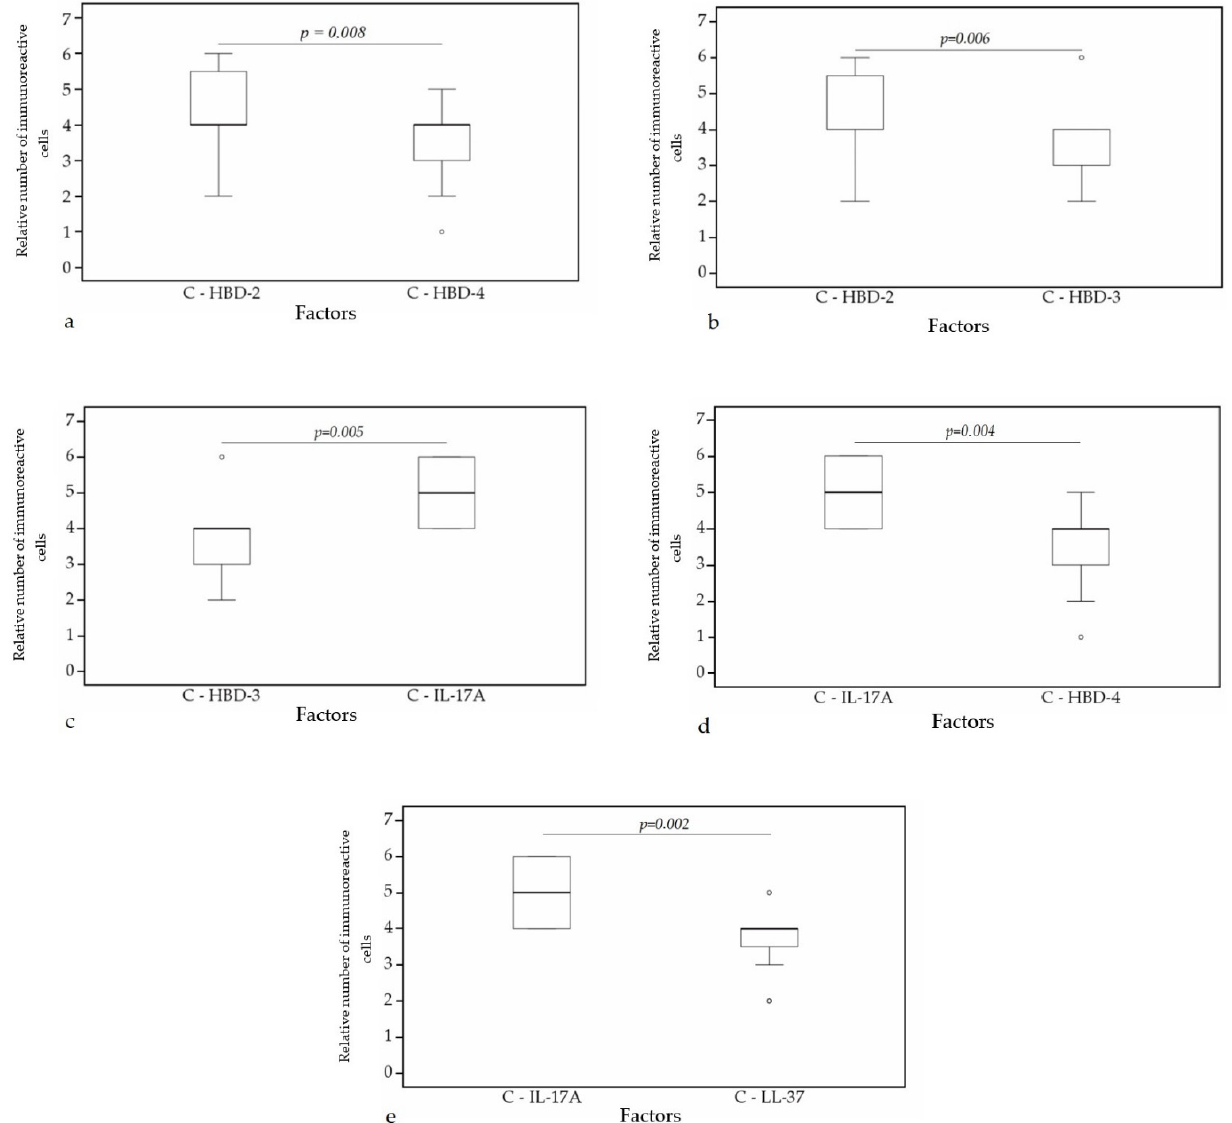
Figure 10. Wilcoxon test revealing statistically significant difference between the relative numbers of different factors in cartilage. ( a ) A statistically significant difference between HBD-2 and HBD-4 in cartilage. ( b ) A statistically significant difference between HBD-2 and HBD-3 in cartilage. ( c ) A statistically significant difference between HBD-3 and IL-17A in cartilage. ( d ) A statistically significant difference between IL-17A and HBD-4 in cartilage. ( e ) A statistically significant difference between IL-17A and LL-37 in cartilage. C, cartilage; HBD-2, human β defensin 2; HBD-3, human β defensin 3; HBD-4, human β defensin 4; LL-37, cathelicidine; IL-17A, interleukin 17A; o—outlier data—indicates a higher or lower relative number of positive cells which lie more than 1.5 but less than 3.0 times the interquartile range below the first quartile or above the third quartile.